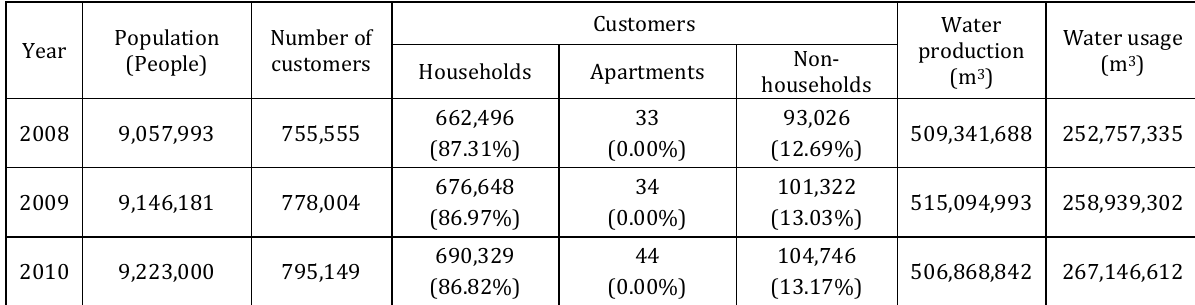
Table 5 . Number of Customers and their Water Use after the Implementation of the Progressive Tariffs (Bureau of Statistic Center DKI Jakarta Province, 2011)